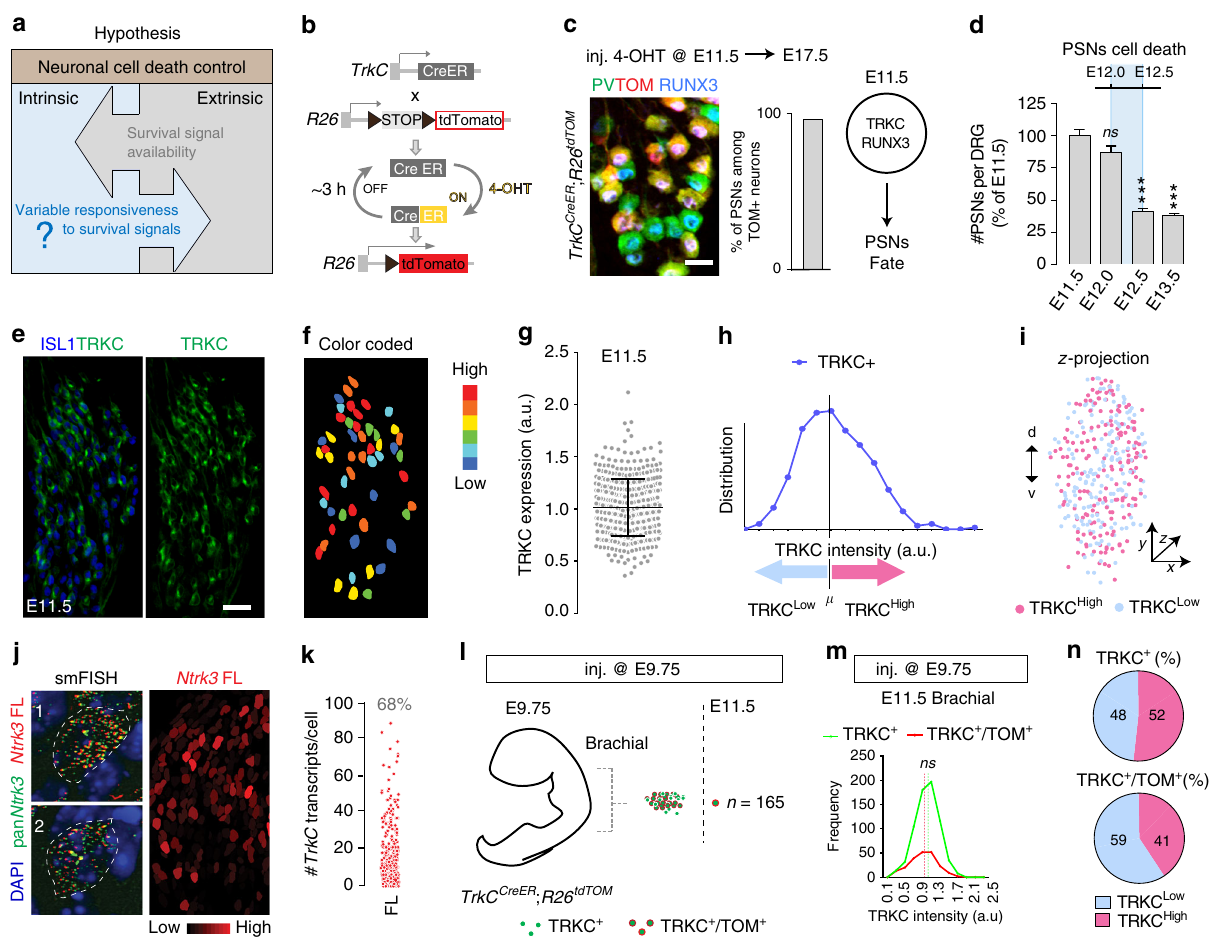
Fig. 1 Differential expression of TRKC in PSNs prior to the cell death period. a Scheme of our working hypothesis. b , c Temporal fate mapping of TRKC PSNs by 4-OHT induction. TrkC CreER mice allow temporary activation of CreER in the TRKC + cells 2 h after 4-OHT injection 21,22 . Immunostaining for PV, RFP and RUNX3 on E17.5 DRG sections ( c ) and graph showing distribution of PV + /RUNX3 + PSNs among the TOM + cells ( n = 4). Scale bar: 20 μ m. d Quanti fi cation of PSNs at C5 and C7. *** P < 0.001, one-way analysis of variance (ANOVA) with Sidak ’ s multiple comparisons test ( n = 2 – 3). The window of PSNs cell death is shown. e TRKC expression in E11.5 ISL1 + (and RUNX3 + , whose staining is not shown for more visibility) DRG neurons. Scale bar: 50 μ m. f TRKC levels in PSNs of e illustrated by color coding; dark blue indicates the lower and red the higher TRKC levels. From here, all observations are done at brachial levels (C5 – 8). g Distribution of TRKC levels in PSNs from e . h Distribution of TRKC levels in PSNs in E11.5 DRG neurons (from g ). The data exhibit a Poisson-like distribution (one representative animal), with the mean used to de fi ne the two different categories of TRKC intensity (TRKC High